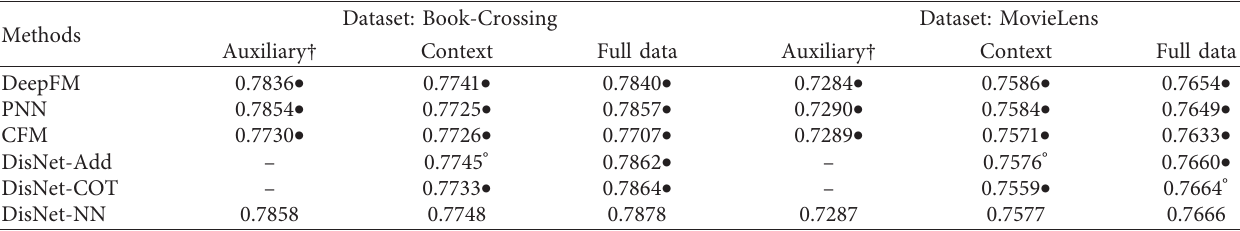
Table 3: Testing AUC comparison of context-aware models on synthetic datasets.